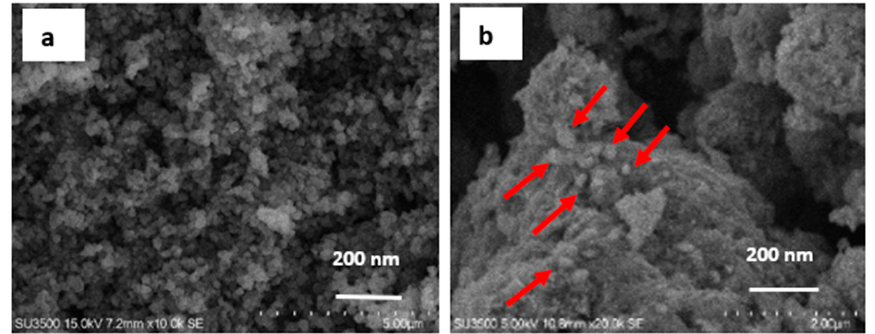
Figure 9. The SEM images of ( a ) TiO 2 –N (10) before and ( b ) TiO 2 –N (10) after being used for Pb(II) photo-oxidation.